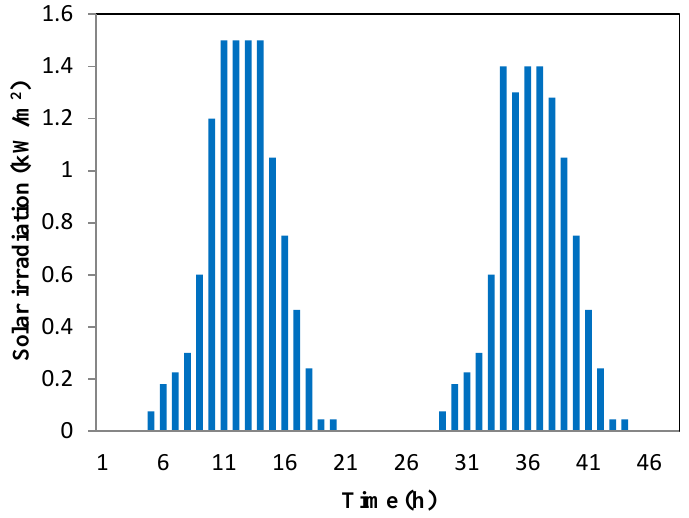
Figure 4. Predicted solar irradiation over a 48 h period.